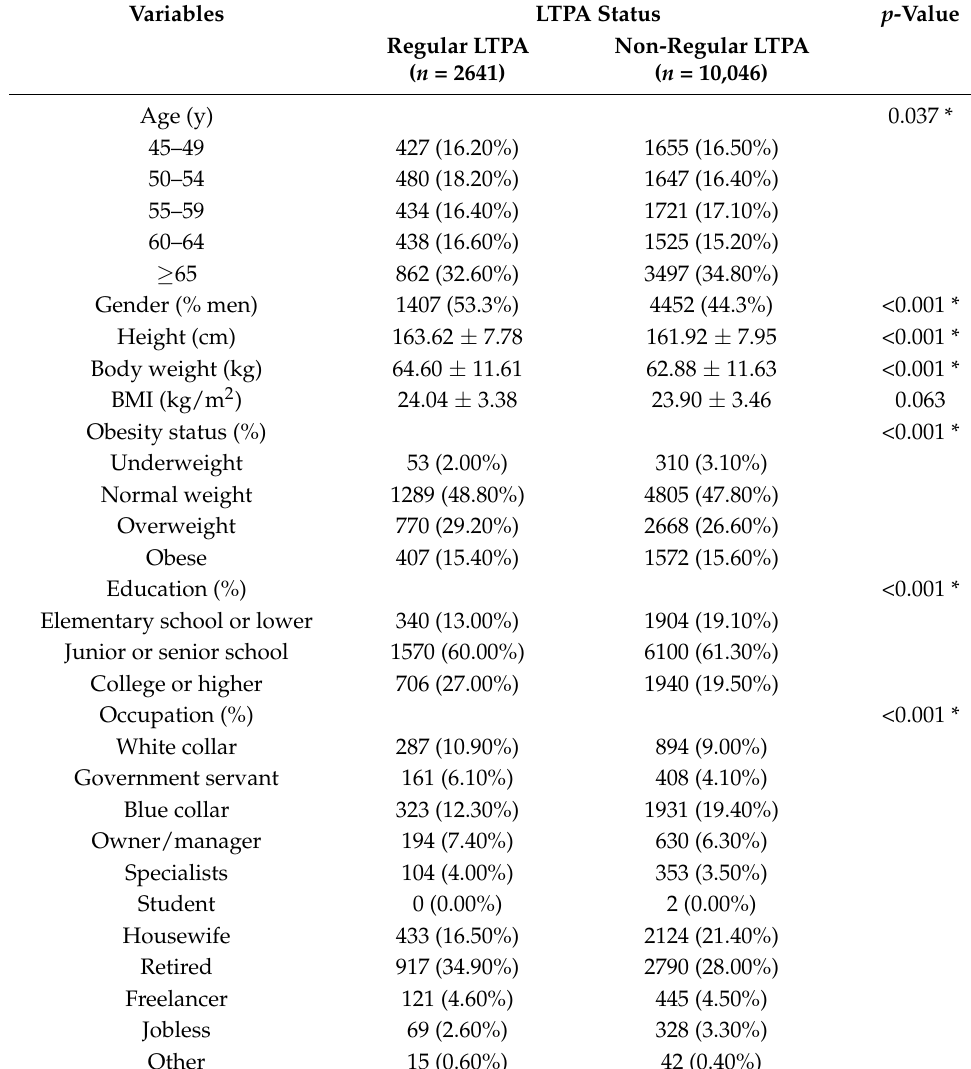
Table 1. Demographic characteristics of